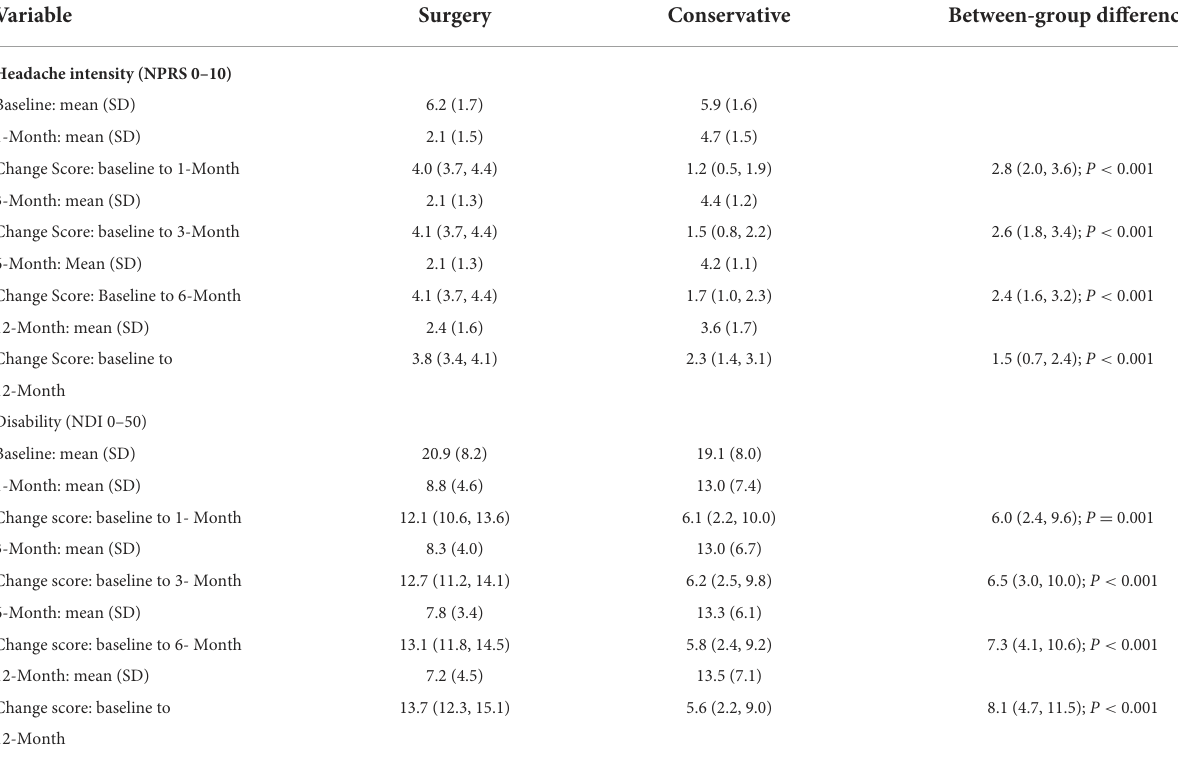
TABLE 3 Changes in headache intensity (NPRS) and disability (NDI) with 95% confidence intervals for both groups and between-group differences. Variable Surgery Conservative Between-group differences